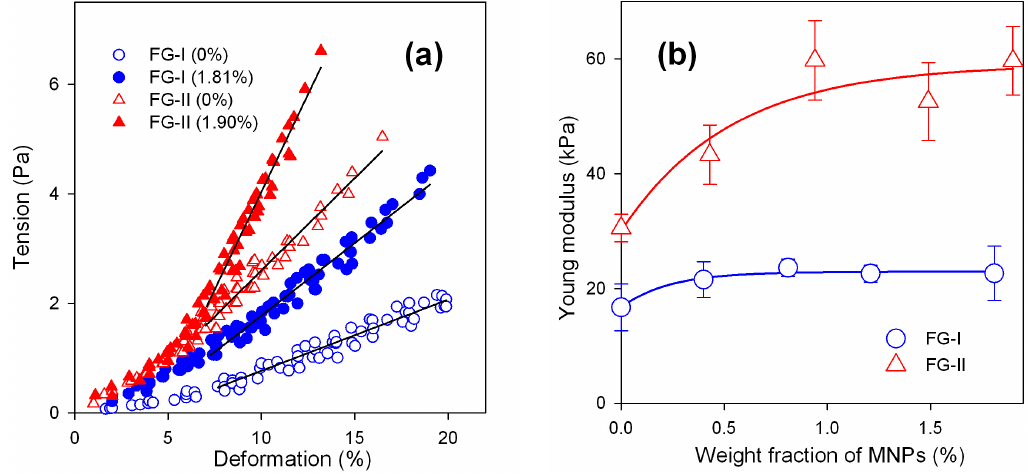
Figure 4. Typical deformation plots for ferrogels of FG-I and FG-II series. Open symbols correspond to unfilled (blank) gel, closed symbols correspond to ferrogel with the highest concentration of MNPs. Lines show the linear parts of the plots, which were used for the calculation of the Young modulus ( a ); Dependence of Young modulus of ferrogel on the weight fraction of MNPs. Lines are for an eye-guide only ( b ).